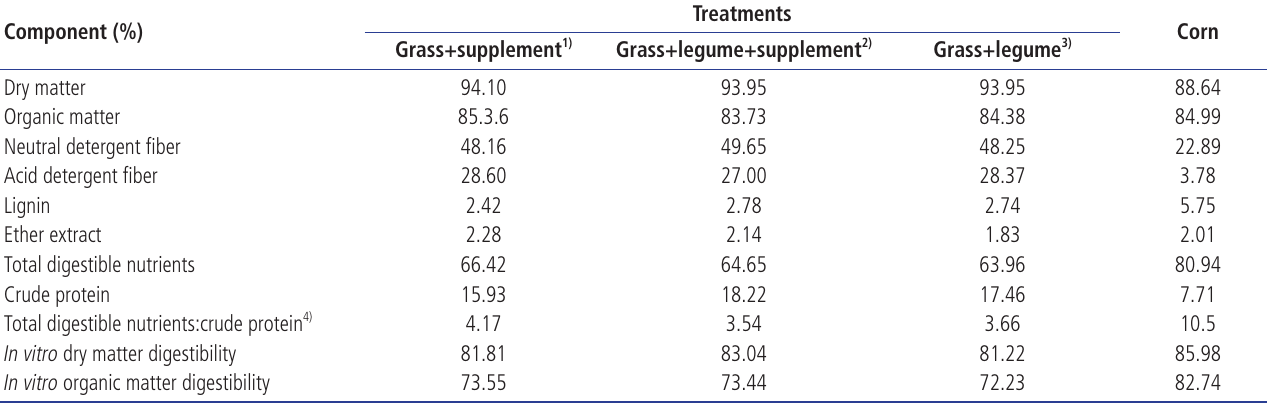
Table 1. Nutritive value of ingredients consumed by beef steers in oat and ryegrass pastures mixed or not with vetch and with or without energy supplementation Component (%)